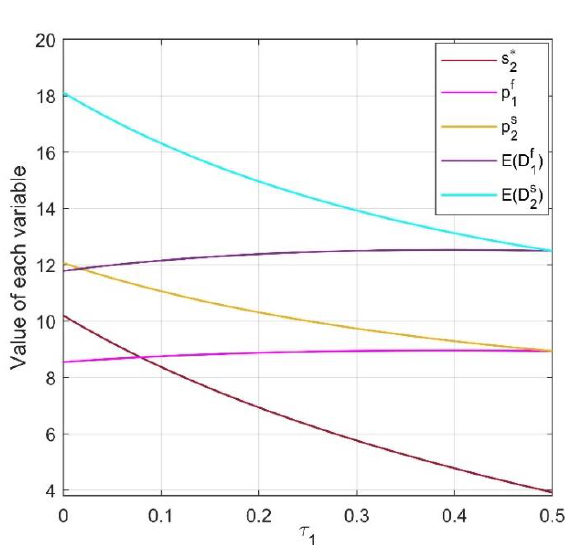
Figure 3. Changes in the value of each variable with τ 1 in the second case.